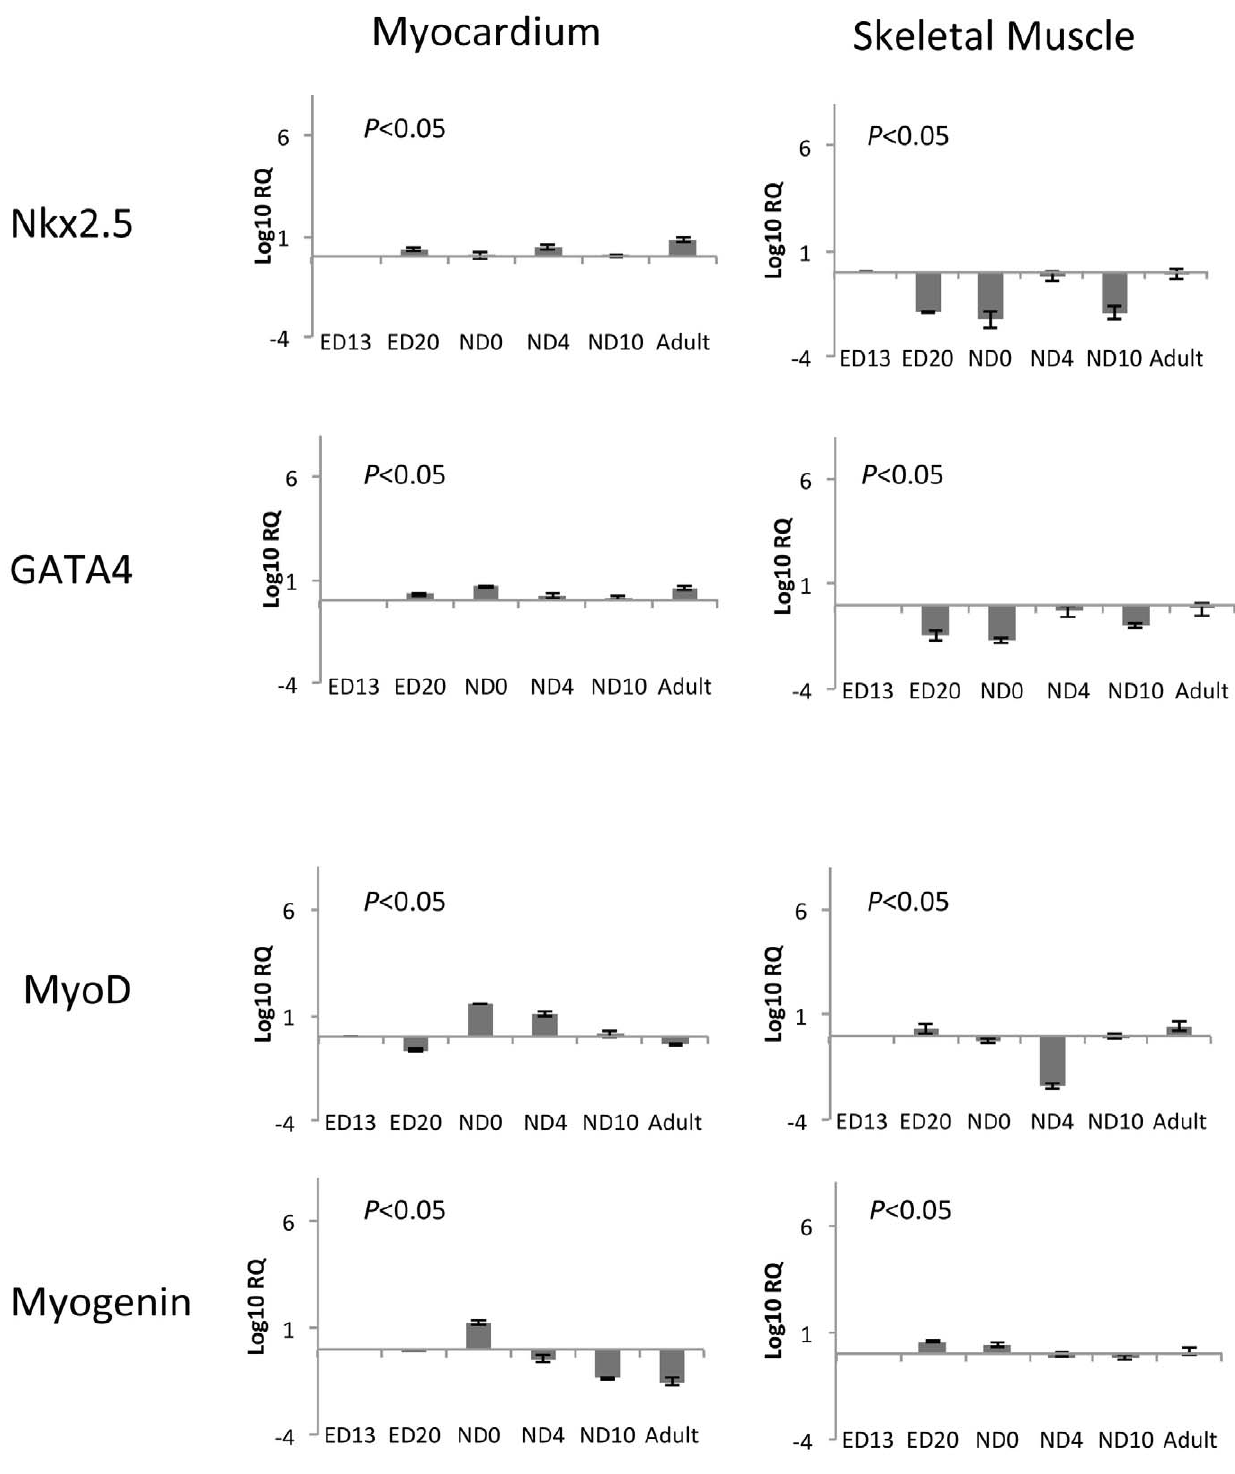
Figure 5. Changes in mRNA levels of cardiac and skeletal muscle specific transcription factors within ventricular myocardium and skeletal muscle. Data are expressed as average 6 SD. Cardiac transcription factors, Nkx2.5 and GATA4, and skeletal muscle transcription factor MyoD expression did not change in ventricular myocardium in adulthood, whereas myogenin expression was significantly decreased in ventricular myocardium ( P , 0.05, ANOVA). Nkx2.5 and GATA4 were significantly decreased during development, and MyoD and myogenin were significantly increased in skeletal muscle during the development ( P , 0.05). Log 10 RQ: Relative Quantification of mRNA level compared to the mRNA level in ED13. The ratio is expressed as logarithm with base value of 10 (Log 10 ).